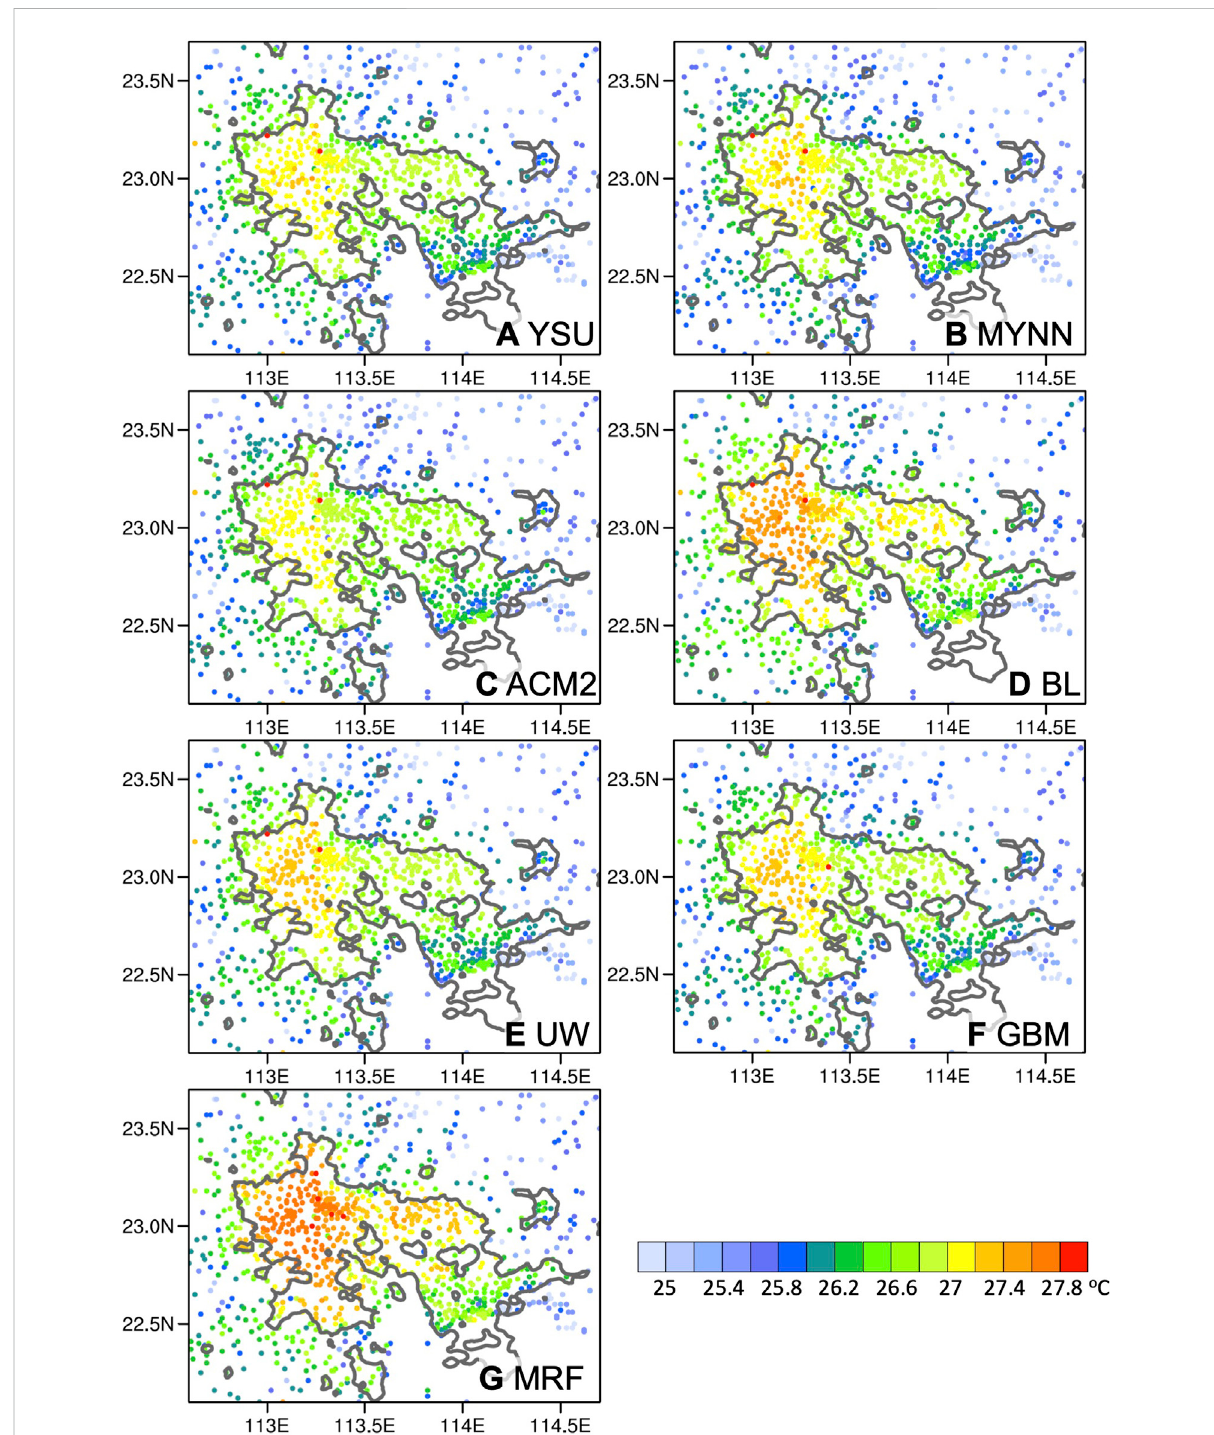
FIGURE 6 Simulateddailyaverageofsurfaceairtemperature(mmday − 1 )averagedfrom2ndAprilto30June2018for (A) YSU, (B) MYNN, (C) ACM2, (D) BL, (E) UW, (F) GBM, and (G) MRF. The gray isopleths denote the urban areas de fi ned by the DMSP nighttime light data in